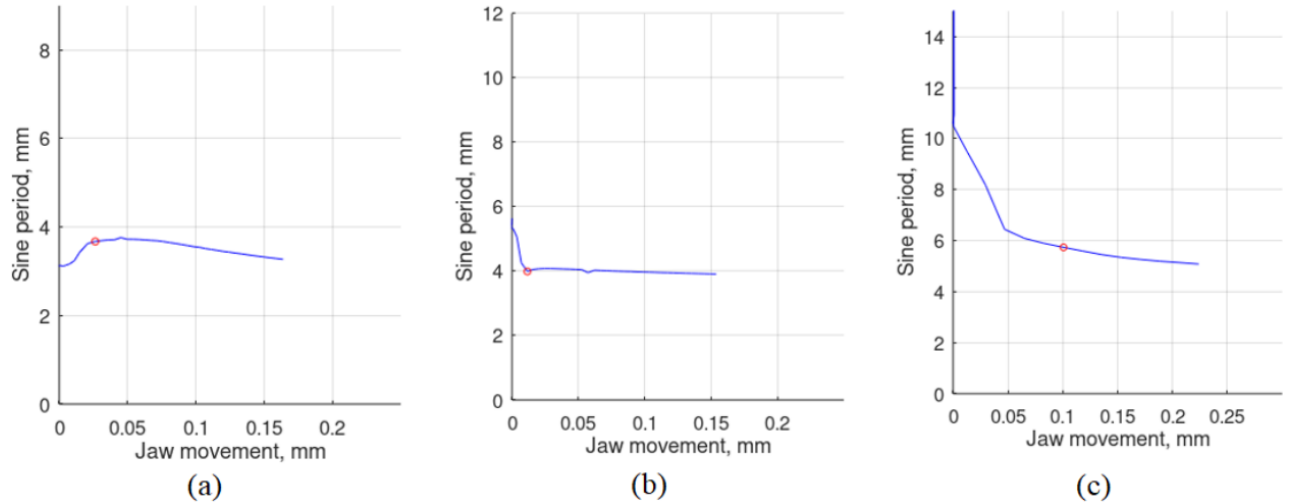
Figure 17. Dependence of the period of the sine wave modelling the shape of the sample on the displacement of the movable handle at the lengths of fastening: ( a ) 3 mm, ( b ) 4 mm, ( c ) 5 mm.